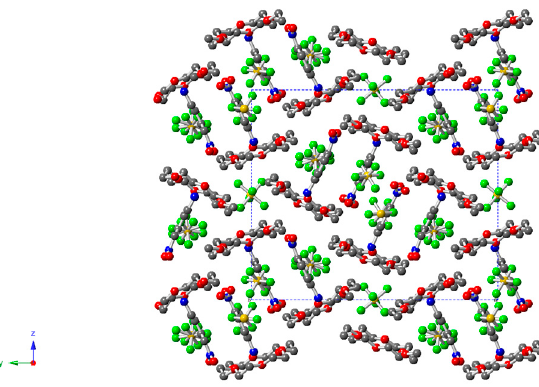
Figure 4. Two kinds of 1D chain molecular structure ( A , B ) between fluorine atom of the PF 6 − anion and the adjacent 4-nitroanilinium cation in compound 1 with C–H···F–P hydrogen bond interactions.